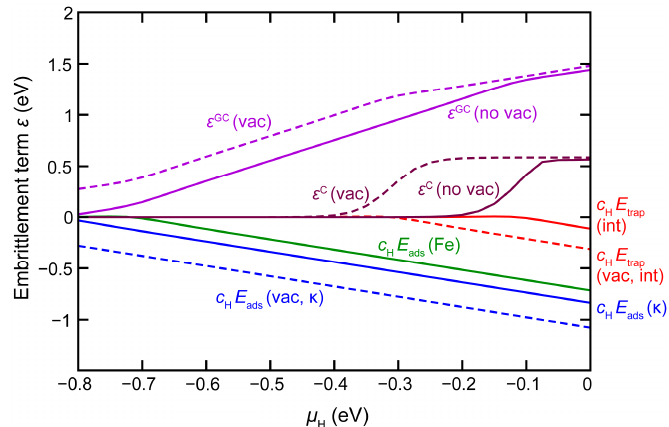
Figure 10. Embrittlement term ε and the different energy contributions in Equation (6) as a function of μ H . A perfect κ -carbide (solid lines) is compared with a κ -carbide that contains a C vacancy (dashed lines). Furthermore, the grand-canonical (GC) and the canonical (C) limit are compared (see text for details).